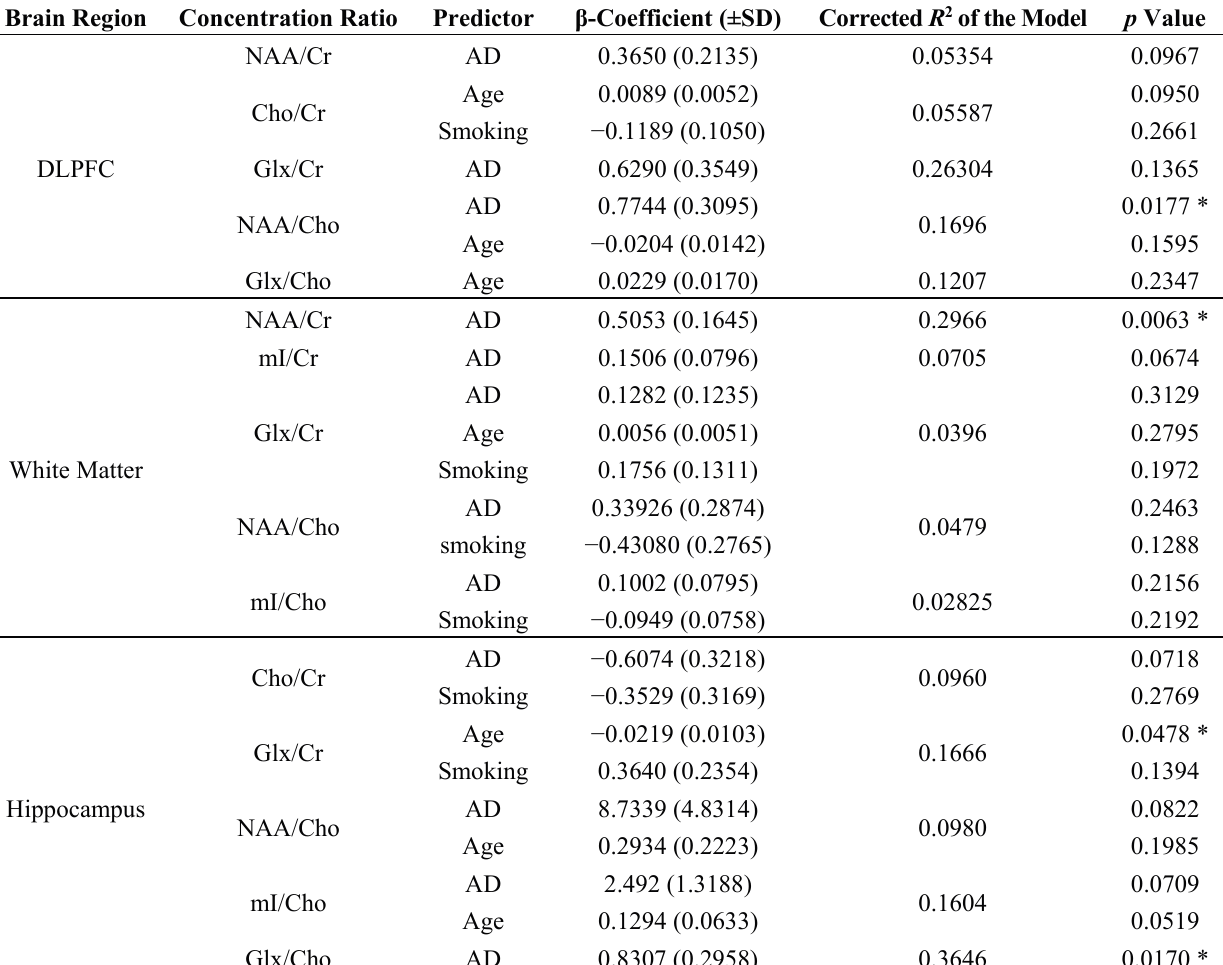
Table 7. Multiple stepwise regression analysis of the determinants of substance concentration ratios in left DLPFC, frontal WM and